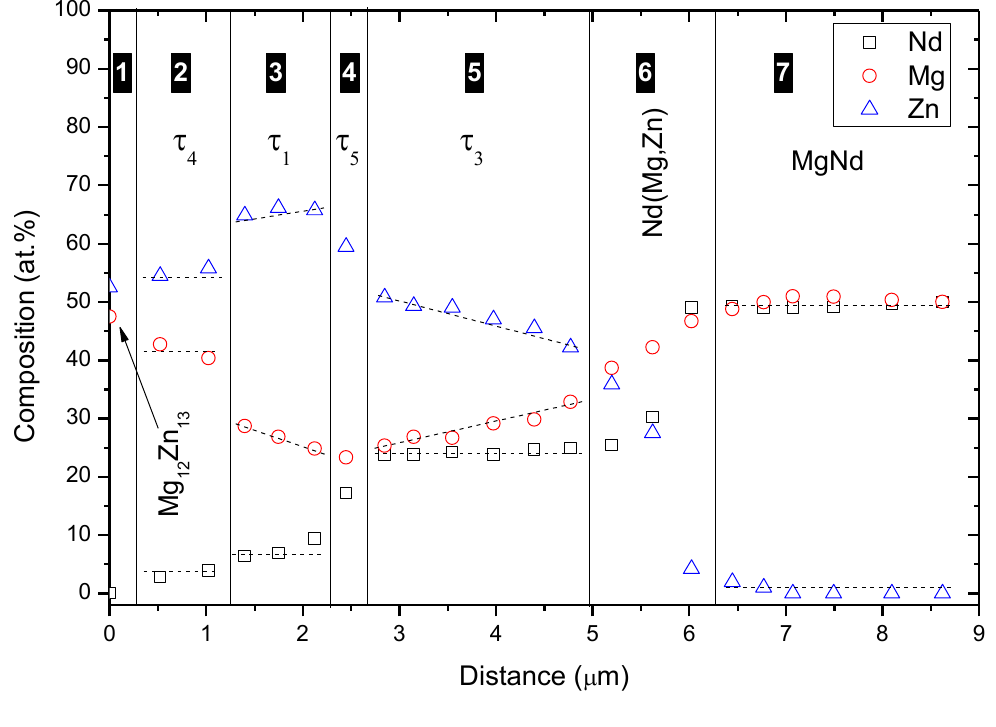
Figure 6. WDS line-scan across diffusion couple #2. Table 2. WDS spot analysis of diffusion zones of diffusion couple